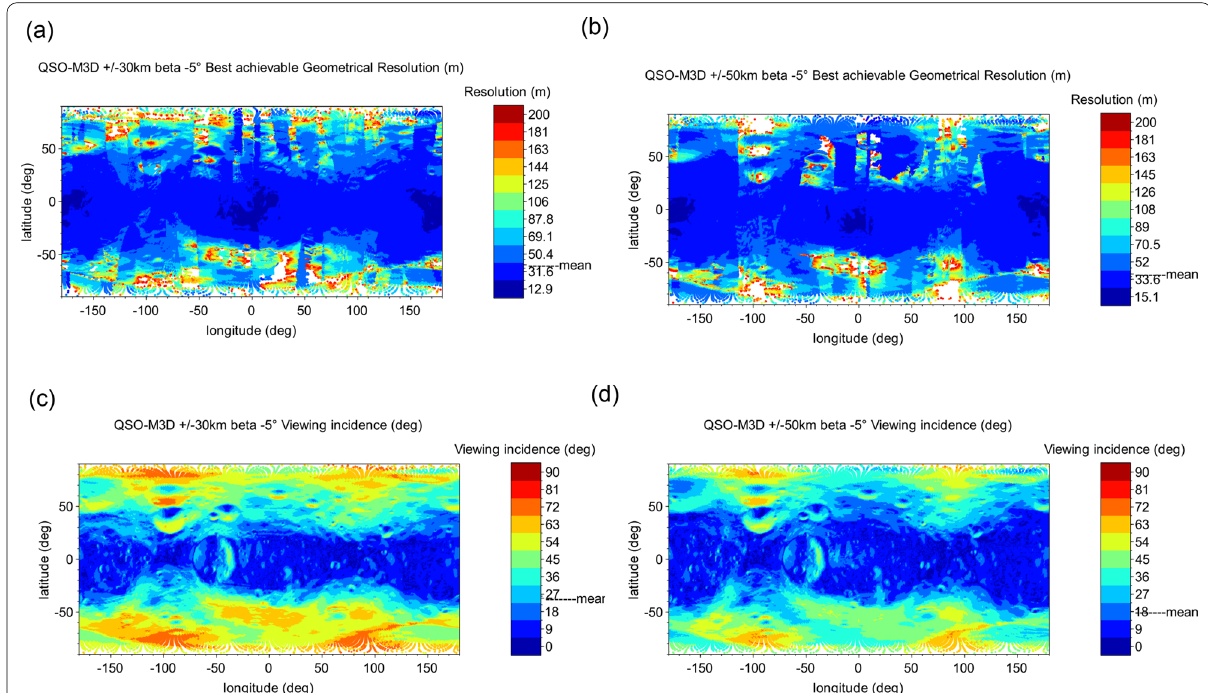
Fig. 11 a Geometric (spatial) resolution distribution of 3D‑QSO with z 30 km and β 5°. Percentage of surface covered at resolution better = ± = − than 100 m is 62% for areas within 30° latitudes and 92% for all areas, at resolution better than 40 m is 29% for areas within 30° latitudes and ± ± 71% for all areas, at resolution better than 30 m is 15% for areas within 30° latitudes and 54% for all areas, at resolution better than 20 m is 3% ± for areas within 30° latitudes and 25% for all areas, and at resolution better than 10 m is 0% for areas within 30° latitudes and 0% for all areas. ± ± b Geometric (spatial) resolution distribution of 3D‑QSO with z 50 km and β 5°. Percentage of surface covered at resolution better than = ± = − 100 m is 63% for areas within 30° latitudes and 92% for all areas, at resolution better than 40 m is 32% for areas within 30° latitudes and 71% ± ± for all areas, at resolution better than 30 m is 17% for areas within 30° latitudes and 51% for all areas, at resolution better than 20 m is 1% for areas ± within 30° latitudes and 16% for all areas, and at resolution better than 10 m is 0% for areas within 30° latitudes and 0% for all areas. c Viewing ± ± incidence distribution of 3D‑QSO with z 30 km and β 5°and d 3D‑QSO with z 50 km and β = ± = − = ± = −